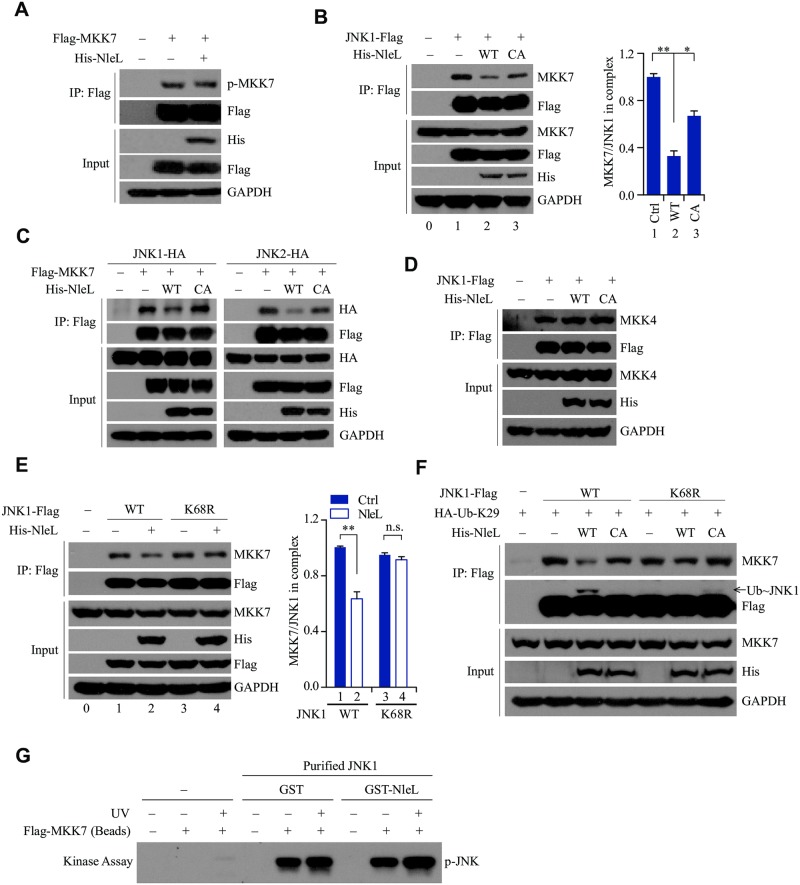
NleL mediated mono-ubiquitylation of JNK1 at Lys 68 inactivates JNK1 through disrupting the JNK1-MKK7 interaction.(A) NleL had little or no effect on MKK7 phosphorylation. HEK293T cells expressing Flag-tagged MKK7 and His-NleL were subjected to IP with anti-Flag, followed by IB with anti-p-MKK7 antibody. (B) NleL disrupted the interaction between JNK1 and endogenous MKK7. HEK293T cells expressing Flag-tagged JNK1 and His6-tagged NleL or the C753A mutant were lysed 24 h after transfection. Co-immunoprecipitation with anti-Flag M2 beads and immunoblotting with anti-MKK7 antibody were performed (left). The MKK7/JNK1 ratios in immunoprecipitate complexes were further determined by quantifying protein bands (right). (C) Co-immunoprecipitation assays of ectopically expressed Flag-tagged MKK7 and HA-tagged JNK1 (left) or JNK2 (right) in the cells expressing His-NleL or C753A. The immuoprecipitates and whole-cell lysates (input) were subjected to immunoblotting with the indicated antibodies. (D) NleL did not disrupt the interaction between JNK1 and MKK4. (E) K68R of JNK1 almost totally abolished the NleL-mediated disruption of the JNK1-MKK7 interaction. HEK293T cells transiently expressed wild-type Flag-tagged JNK1 or the K68R mutant with or without His6-tagged NleL. Cells were treated with TNFα (10 ng/ml) for 10 min before being lysed. Then immunoprecipitation with anti-Flag M2 beads and subsequent immunoblotting with anti-MKK7 antibody were performed. The MKK7/JNK1 ratio in immunoprecipitates (right) were further determined by quantifying the densities of the concerned protein bands. (F) NleL suppressed the interaction between JNK1 and MKK7 by promoting mono-ubiquitylation on Lys 68 of JNK1. HEK293T cells were transfected with indicated plasmids for 24 h, following by TNFα (10 ng/ml) stimulation for 10 min. (G) Co-expression of GST-tagged NleL and His6-tagged JNK1 in bacteria showed no effect on JNK1 phosphorylation by MKK7 in vitro. His6-tagged JNK1 was purified by using Ni-NTA beads from E. coli BL21 (DE3) strain co-expressing His6-tagged JNK1 and GST-tagged NleL or GST only. HEK293T cells expressing Flag-tagged MKK7 (with or without UV stimulation) were lysed in M2 buffer and subjected to anti-Flag immunoprecipitation. Then the beads bounded with Flag-tagged MKK7 were subjected to in vitro kinase assay with bacterially purified His6-tagged JNK1 as the substrate, followed by IB analysis with anti-p-JNK antibody. In (B), (E), Bars represent means ± s.d. from three biological replicates, *P < 0.05, **P < 0.01, n.s., not significant. (Student’s t-test, data are from three independent experiments, (n = 3)). Blots are representative of at least three independent experiments.